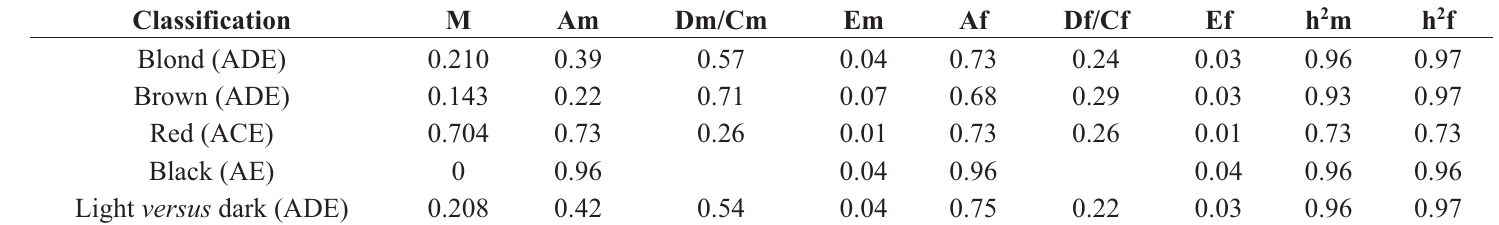
Table 2. The heritability and other parameters estimated from A (D or C) E model for hair color (N = 20,142